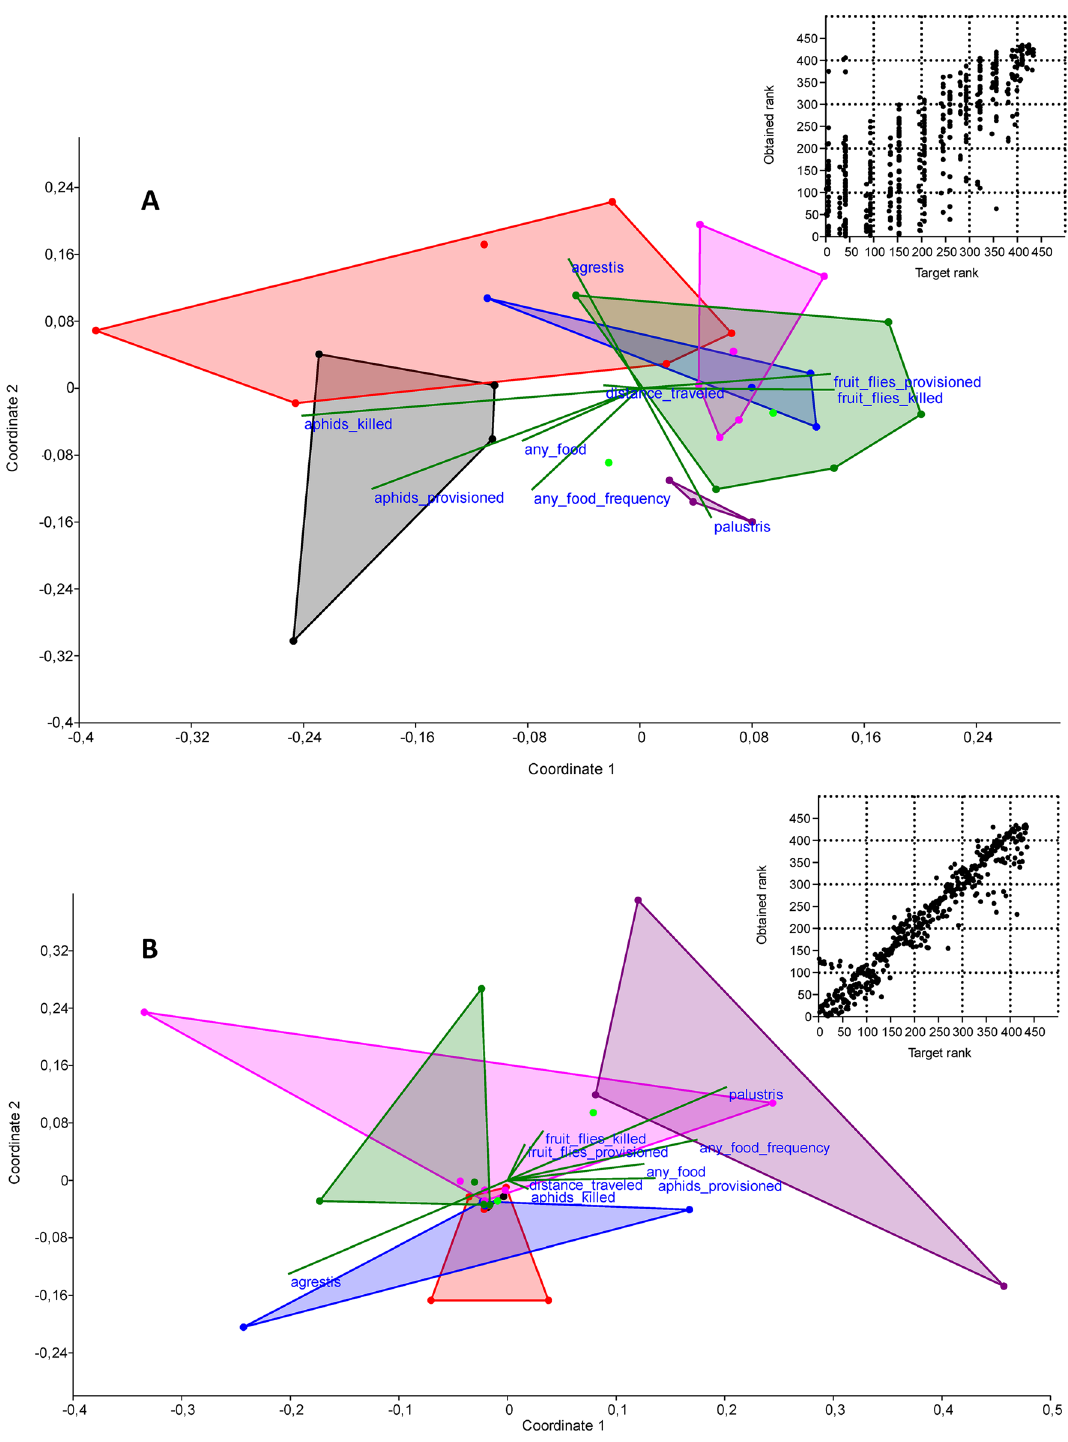
Figure 3. NMDS plots of the effects of environmental variables (provisioned food, frequency of any provisioned food, P. agrestis / P. palustris , number of provisioned aphids, number of provisioned fruit flies, number of killed aphids, number of killed fruit flies, traveled distance) on the analyzed microbial endosymbionts. ( A ) NMDS (Kimura similarity measure) of bacterial and archaeal phyla; stress ratio 0.3363; R 2 (axis 1) 0.000; R 2 (axis 2) 0.0117. ( B ) NMDS (Gower similarity measure) of the relative abundance of selected genera of obligate or facultative endosymbionts; stress ratio 0.1181; R 2 (axis 1) 0.7152; R 2 (axis 2) 0.6924. The Shepard plots (inserts) suggested low concordance of obtained and target ranks in ( A ) but high concordance in ( B ). Grey = P. agrestis , provisioned with aphids twice daily; red = P. agrestis , provisioned with aphids once daily; blue = P. agrestis , starved control; pink = P. agrestis , provisioned with fruit flies twice daily; dark green = P. agrestis , provisioned with fruit flies once daily; violet = P. palustris , provisioned with aphids twice daily; light green = P. palustris , provisioned with fruit flies once daily. Points show host individuals; convex hulls indicate host individuals of the same